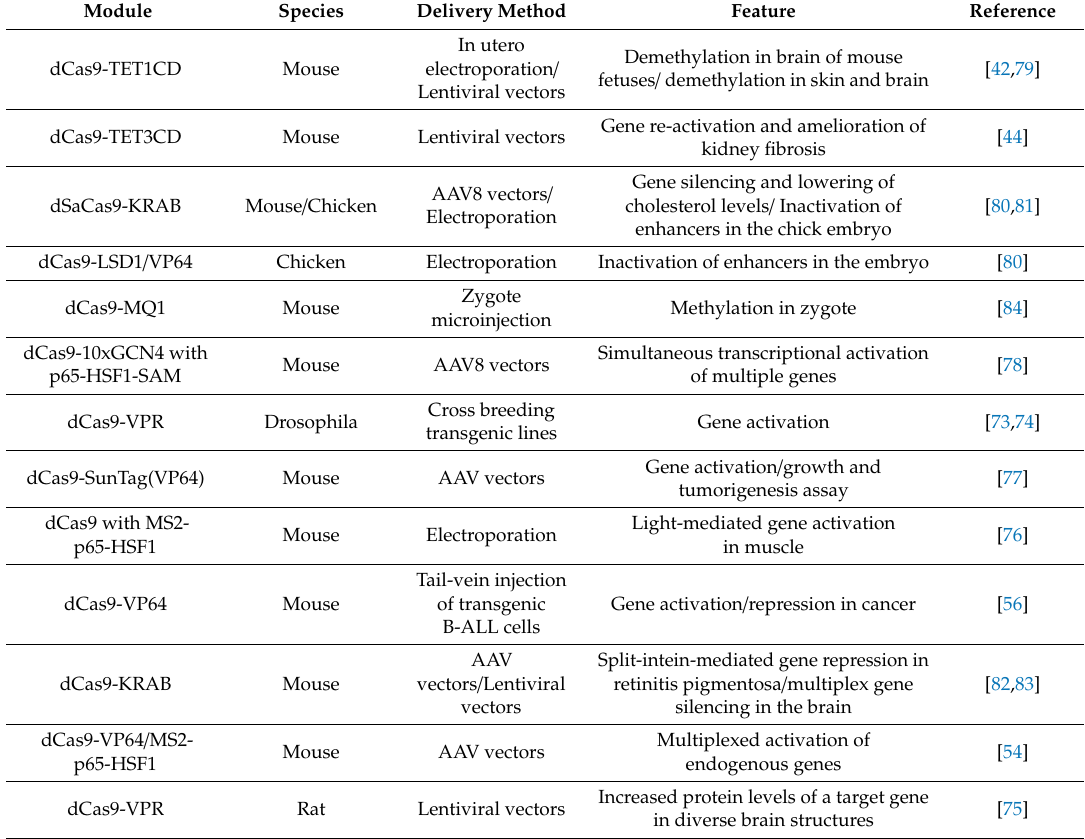
Table 4. In vivo applications of dCas9